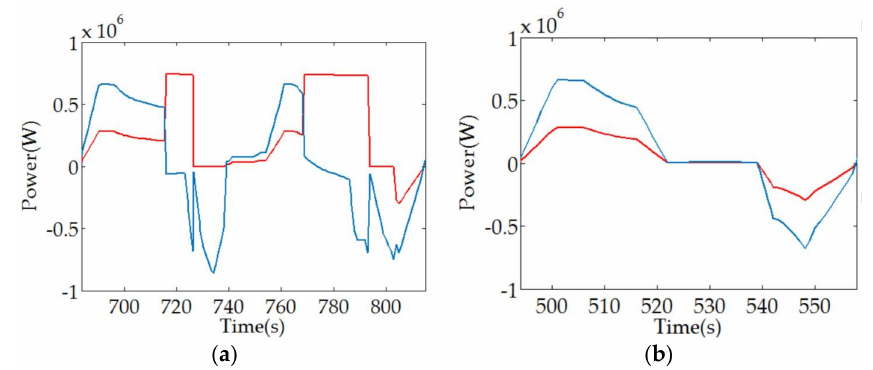
Figure 15. Output power curves of the battery and the supercapacitor. ( a ) Long station spacing. ( b ) Short station